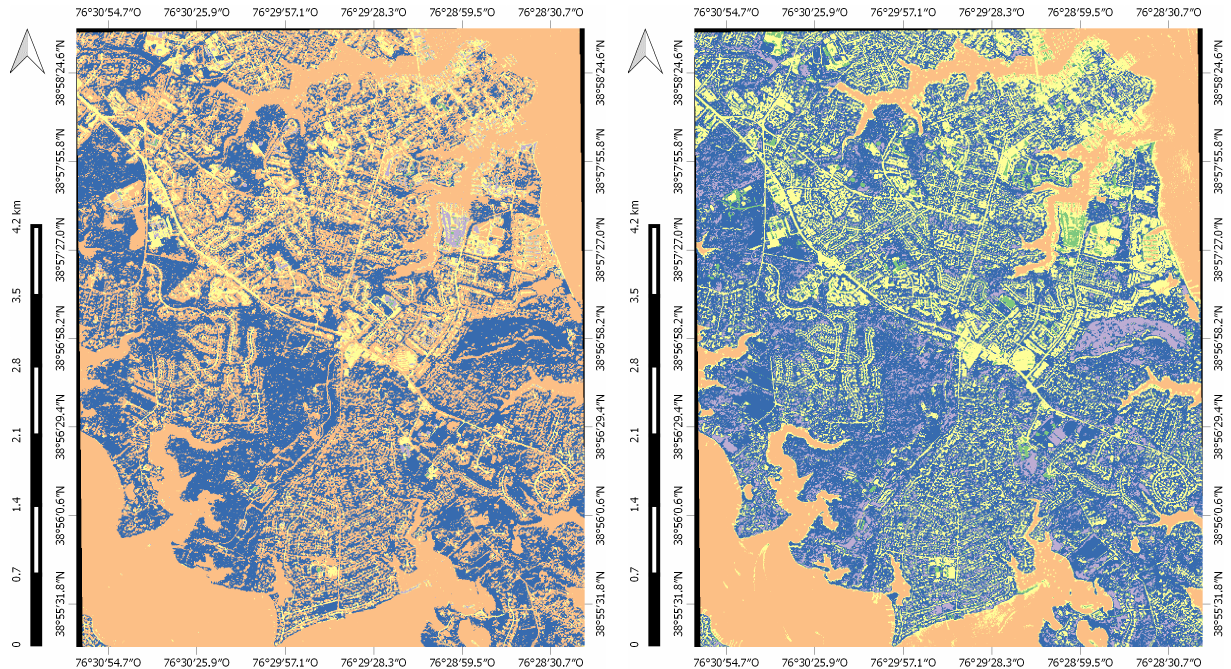
Figure 7. Region-merging methods’ comparison. Results for the image MARYLAND using the color distance region-merging method (left image) and the co-occurrence in the superpixel method (right image) for five final spectral clusters. Colors have no special